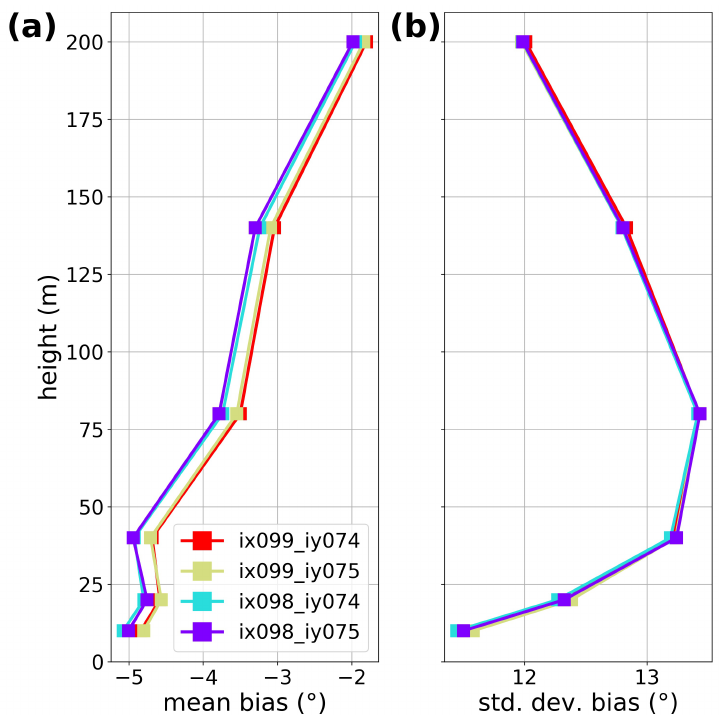
Figure A6. Height profile of ( a ) the mean bias and ( b ) standard deviation of the bias of the wind direction data, comparing the four nearest grid points of